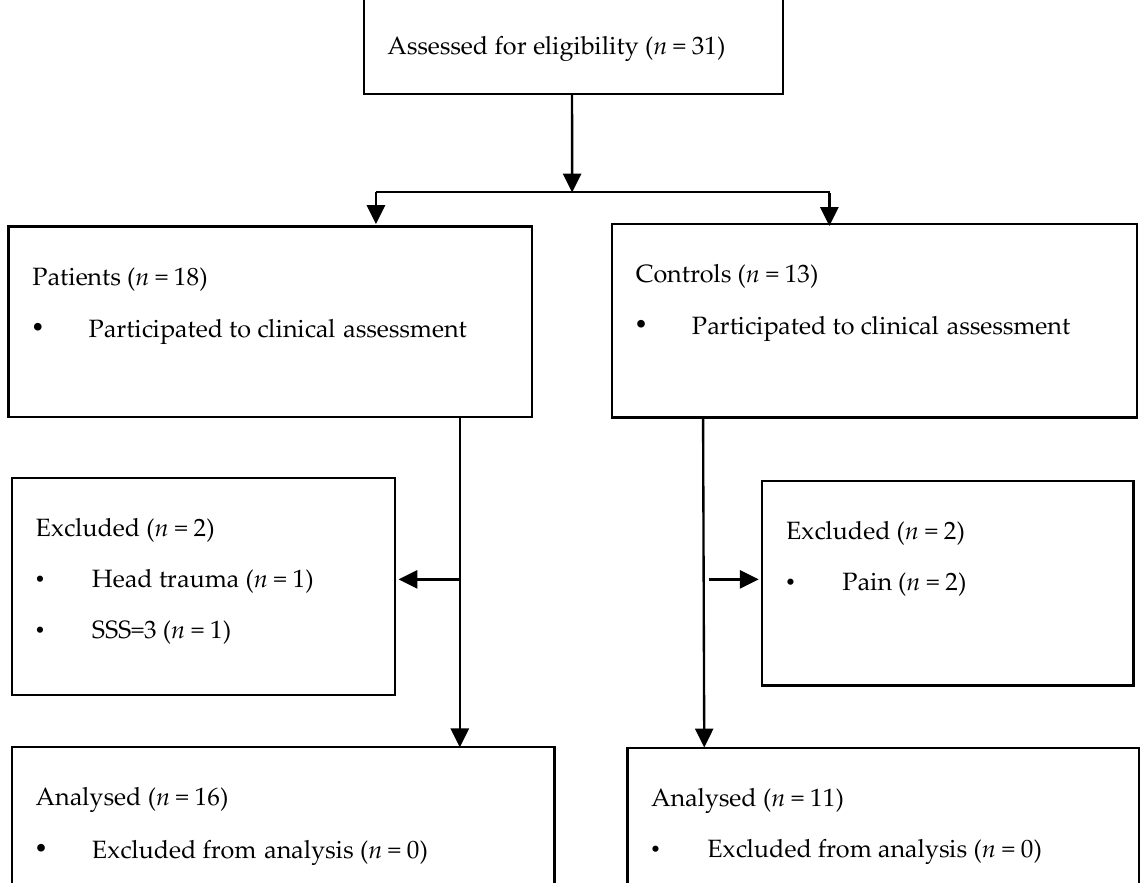
Figure 1. Overview of the selection procedure for participants in the study. In total, 31 participants were screened (18 patients and 13 controls). Two patients were secondarily excluded from the analysis because they finally presented one exclusion criterion each (head traumatism and one of the FM diagnosing score below defined limit). The two excluded controls complained of pain when they were interviewed.